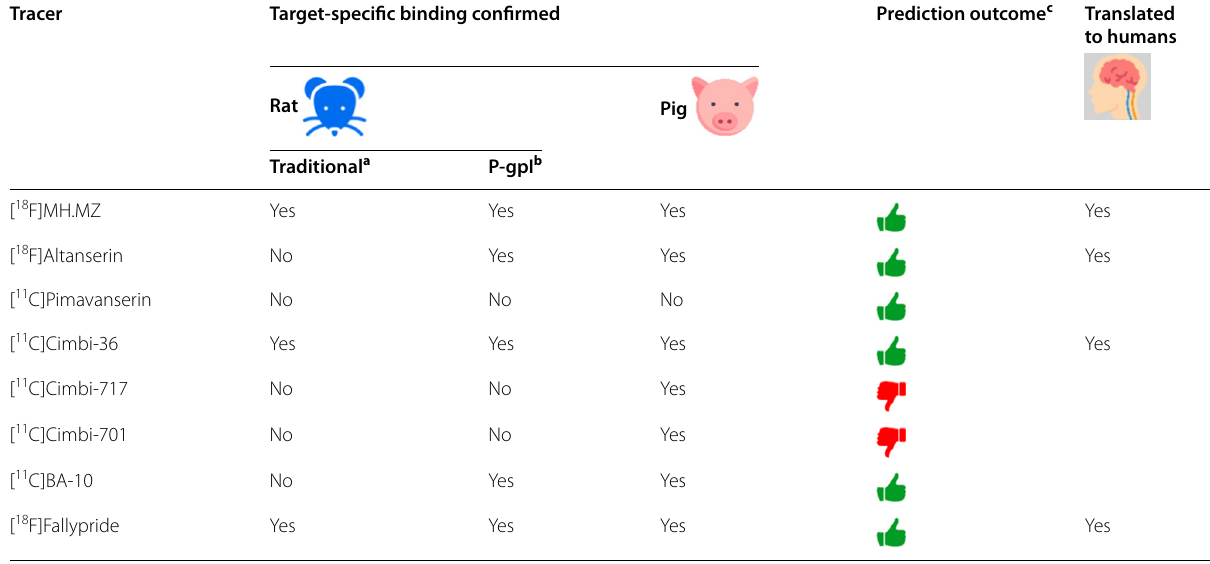
Table 2 Short summary of tracer evaluation in rats, pigs and